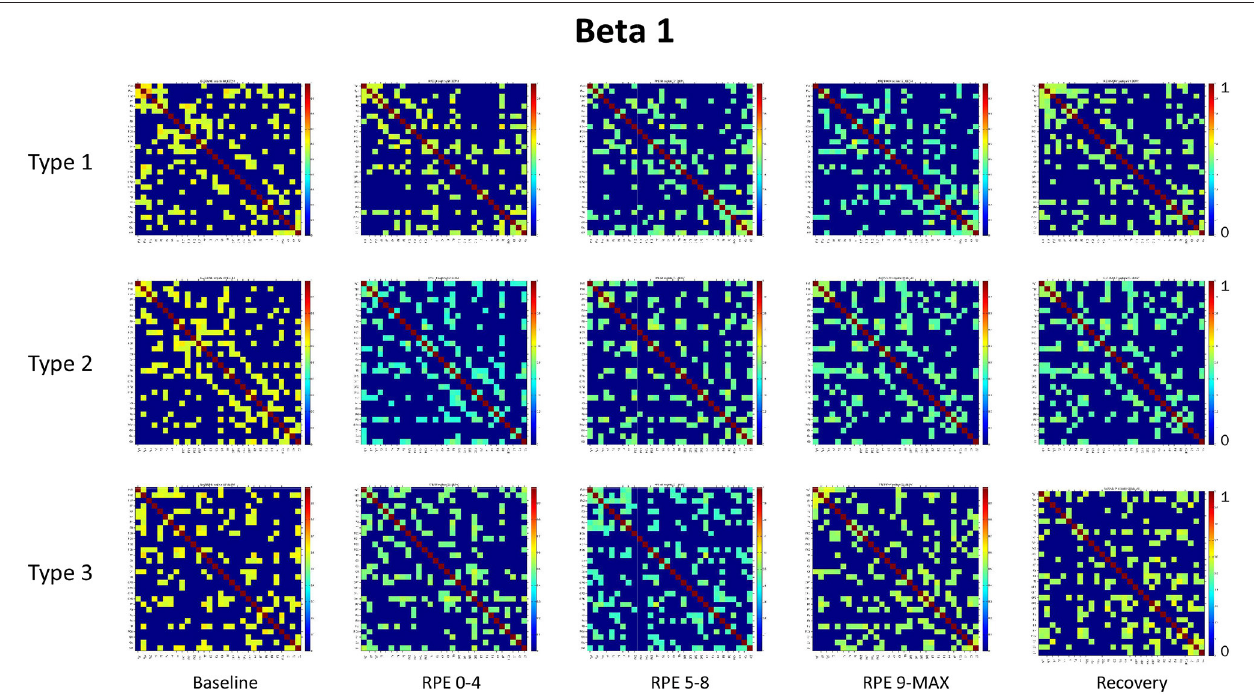
FIGURE 2 | Coherence matrices for each type of performance during different time periods of the protocol in the beta 1 band. Red color indicates high values of coherence whereas the blue color indicates low values of coherence.